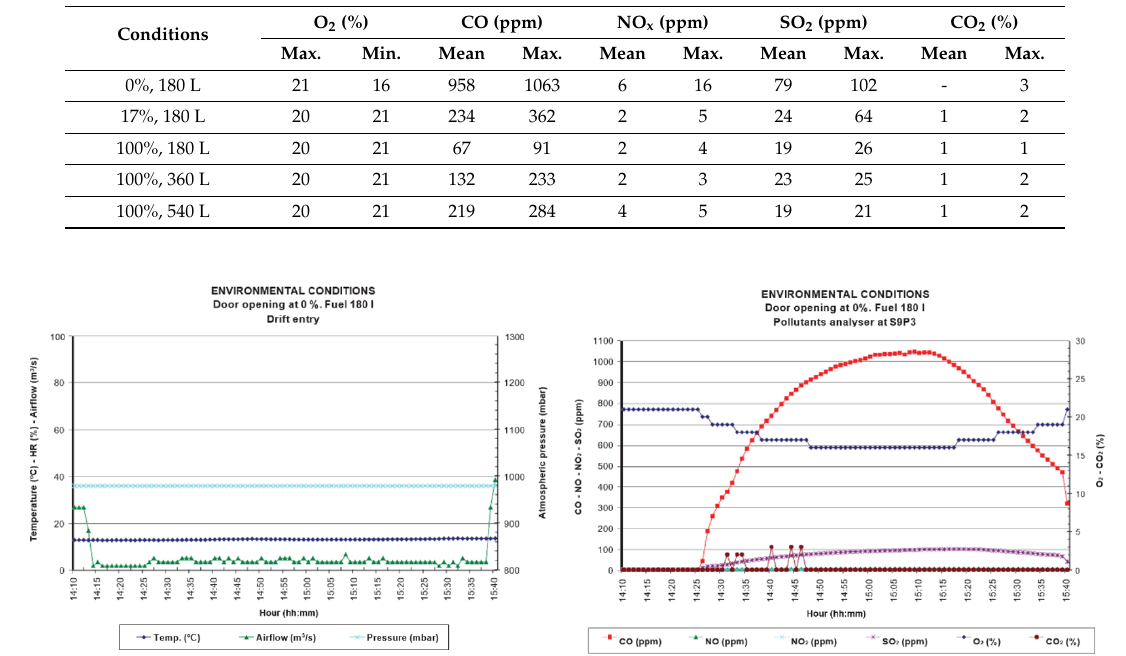
Table 4. Average values of the combustion pollutants.